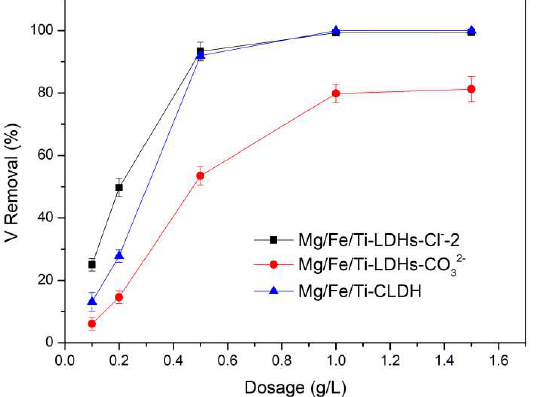
Figure 6. Adsorbent dosage on vanadate adsorption onto Mg-Fe-Ti-LDHs-Cl − -2, Mg-Fe-Ti-LDHs- CO 32 − and Mg-Fe-Ti-CLDH (experimental conditions: C 0 = 10 mg/L, adsorbent dosage = 5–75 mg, pH = 5, contact time = 24 h, T = 298